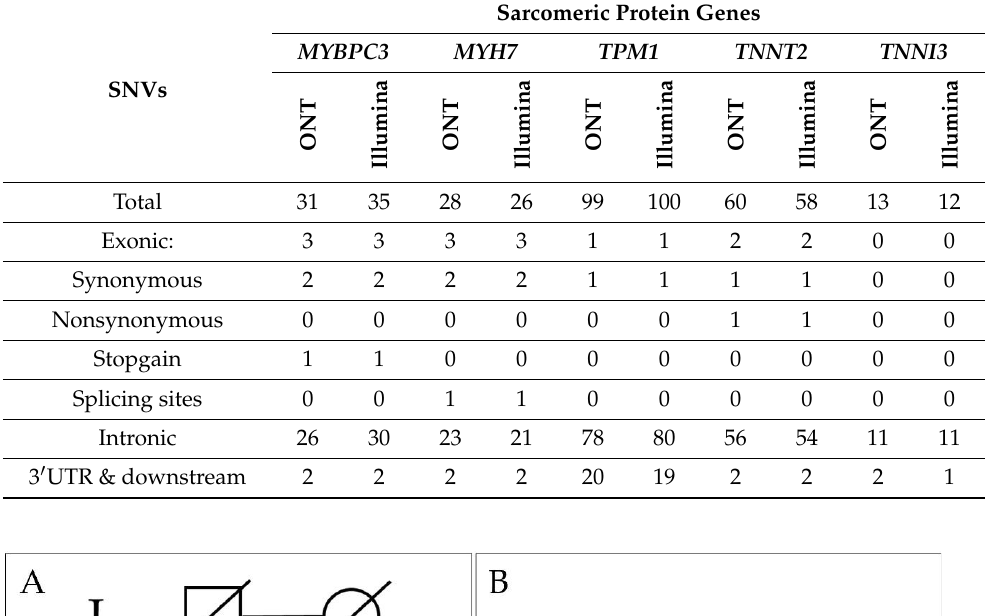
Table 2. SNV-calling summary for five sarcomeric protein genes of the four patients with HCM.